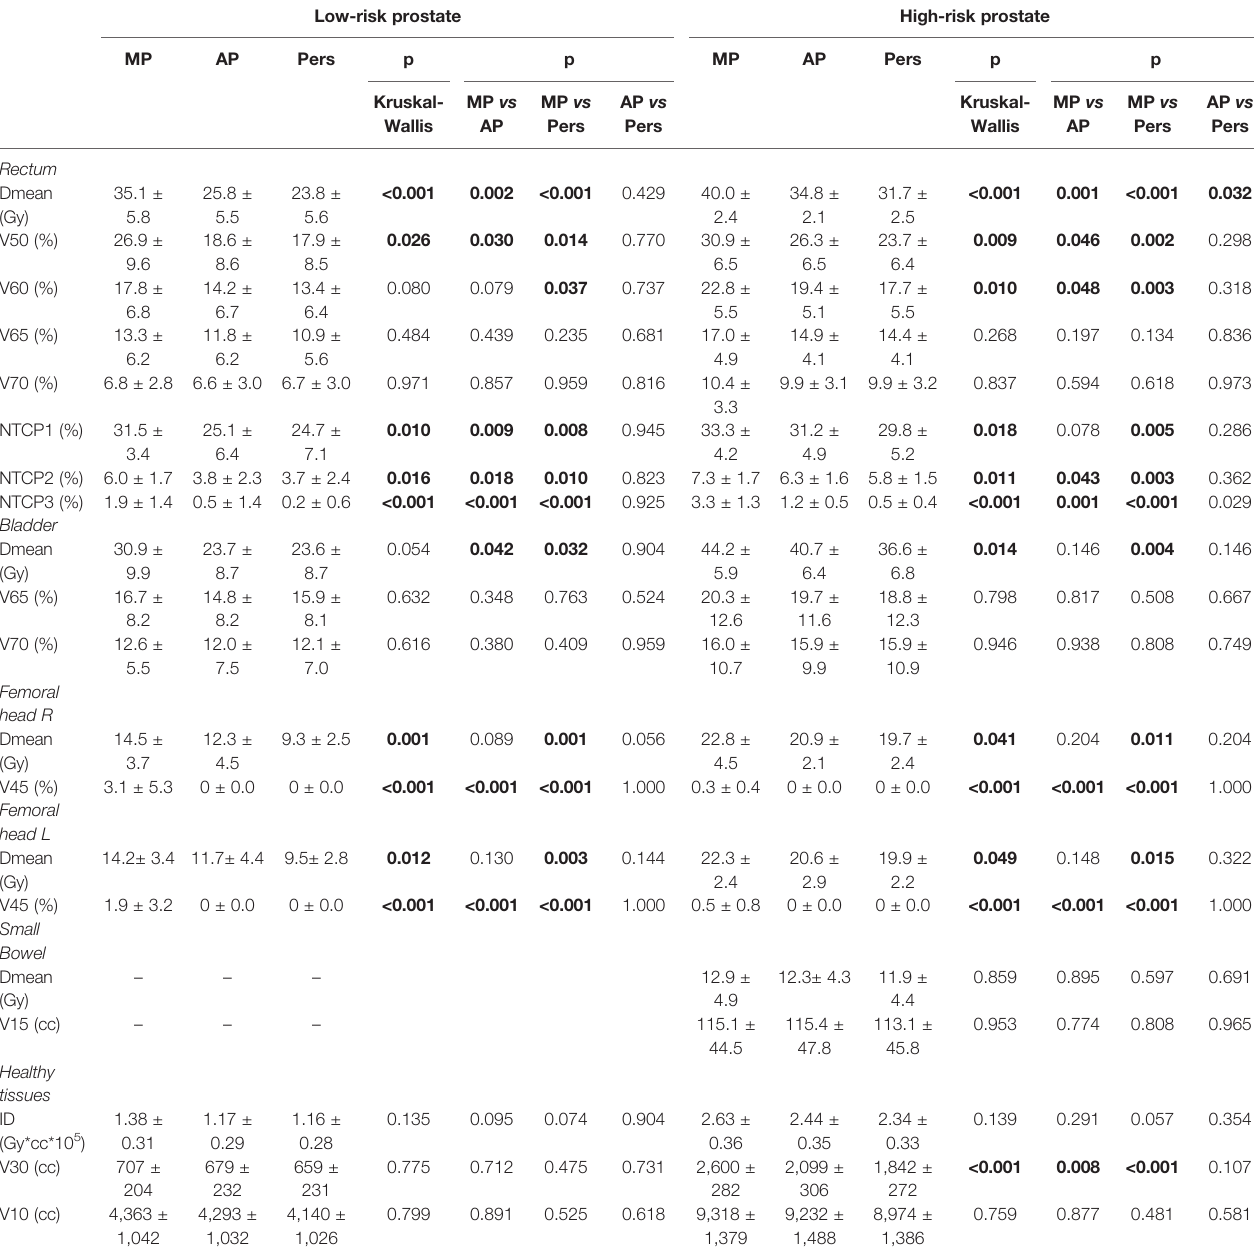
TABLE 4 | Comparison of dosimetric metrics between manual and automated plans for OARs. Low-risk prostate High-risk